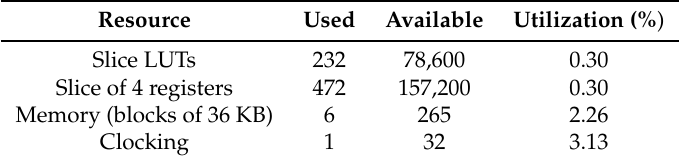
Table 1. Resources usage of the FAST detector design in Xilinx/Zynq-7030 FPGA.